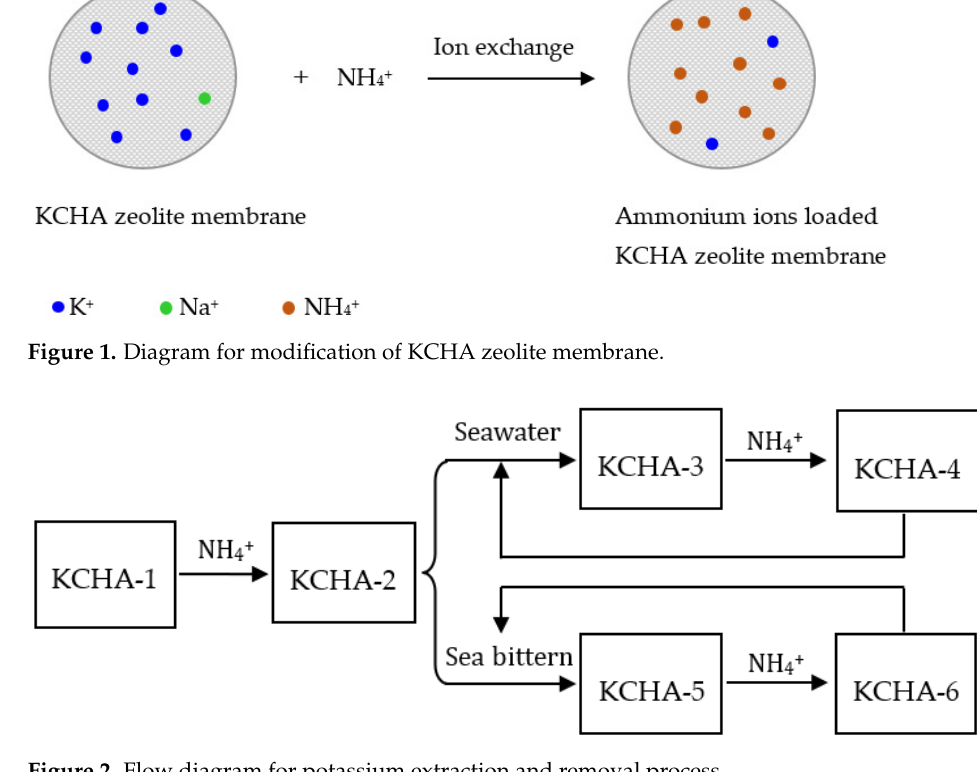
Figure 2. Flow diagram for potassium extraction and removal process.